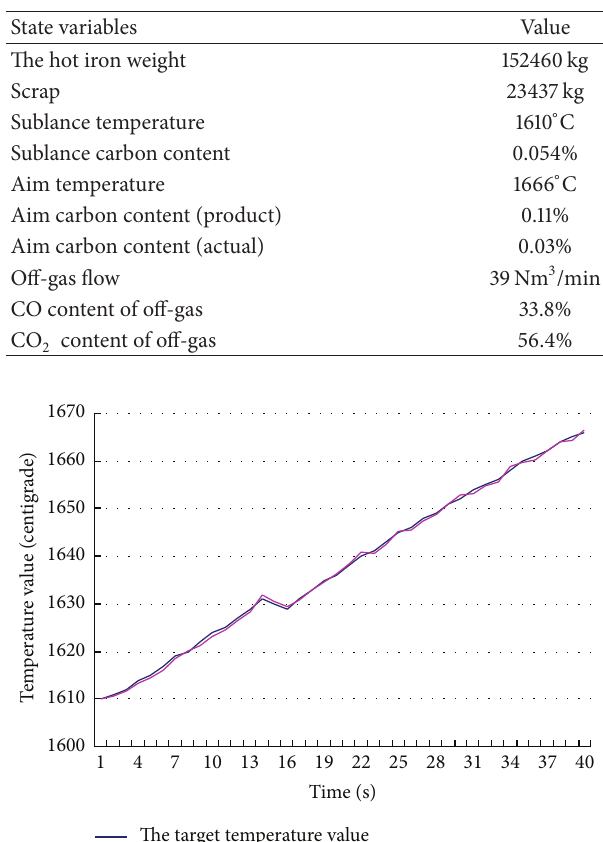
Table 5: The information of the current practical production.